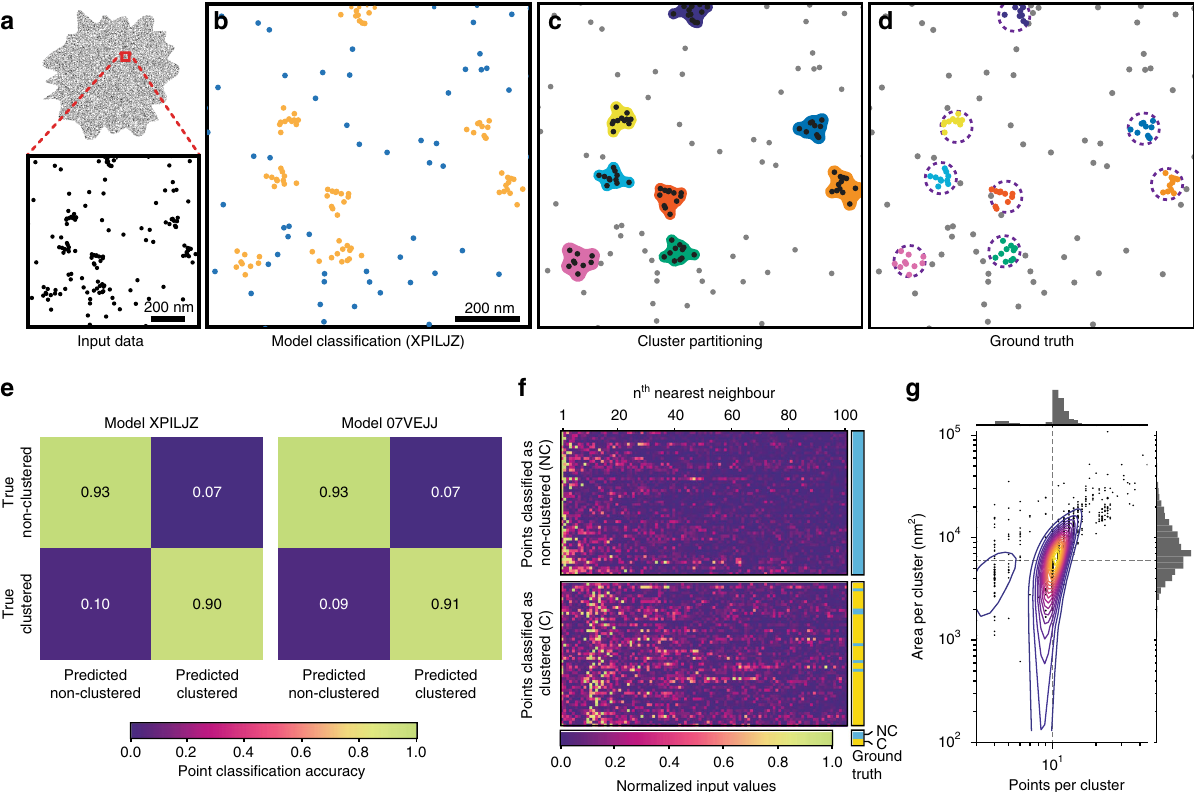
Fig. 2 Testing of two example models using simulated data. a Input data are the point coordinates, which are evaluated ( b ) by a model and classi fi ed as either clustered (gold) or non-clustered (blue). This information is used to partition the clustered points into spatially similar clusters, around which a cluster shape can be formed ( c ). The original (known) clustering assignment ( d , dashed circles indicate the maximum distance clustered points may be positioned from the cluster center) may be used in comparison to assess the accuracy of the process. Accuracy is represented as confusion matrices ( e ) for two models generated using different con fi gurations which report good accuracy. f A random sample of the normalized input data (to 100 near neighbors), separated into those points which were classi fi ed by Model XPILJZ as non-clustered (top) or clustered (bottom); the true label for each point is shown on the right (blue: non-clustered, yellow: clustered). g Output data faithfully describes the original clustering scenario, here the clusters contained 10 points within a maximum radius of 40 nm (indicated by dashed